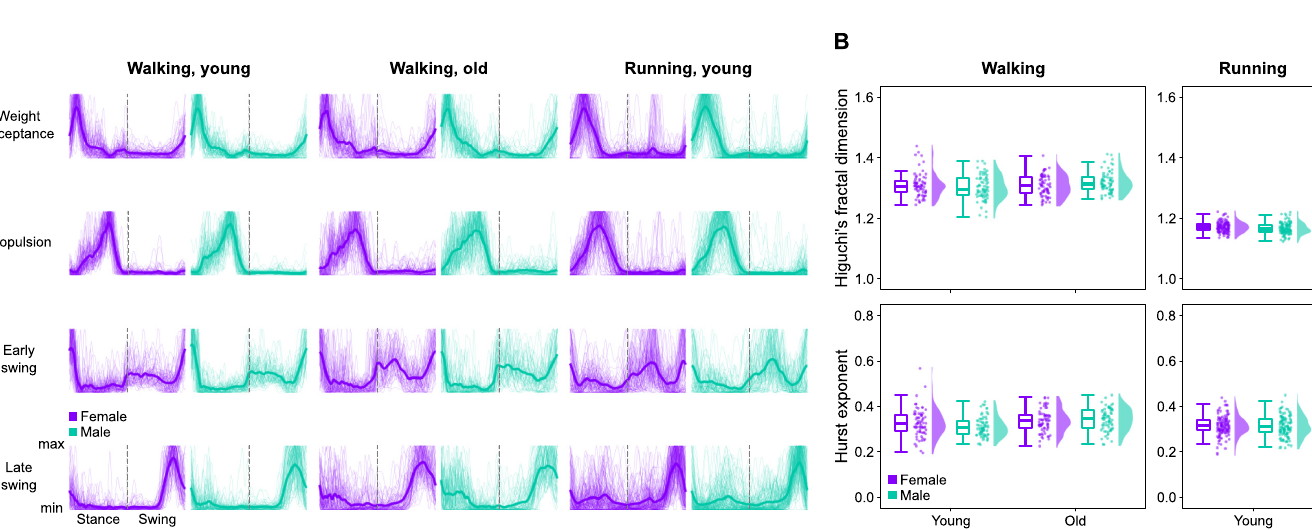
Fig 7. Motor primitives and their fractal properties. (A) Overall average motor primitives (thick lines) and each participant’s average motor primitive (thin lines). (B) Boxplots describing the Higuchi’s fractal dimension and the Hurst exponent of the extracted motor primitives. Raw data points (dots represent the mean value from every participant) and their density estimates are presented to the right side of each boxplot.